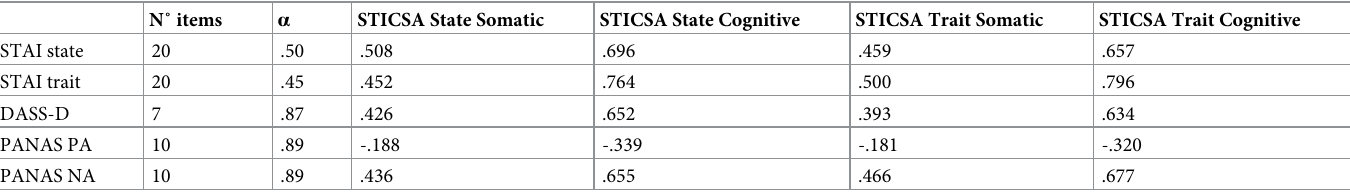
Table 5. Cronbach’s α and Pearson correlation between STICSA factors and anxiety (STAI), depression (DASS-D), positive affect (PA) and negative affect (NA). N˚